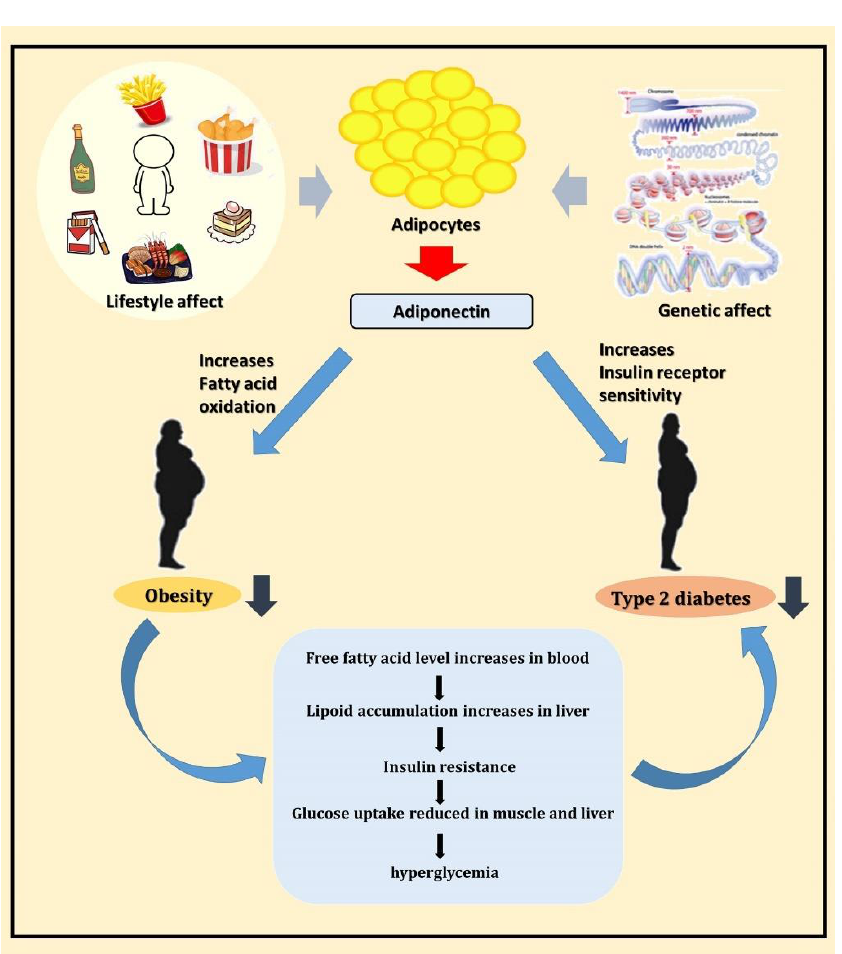
Figure 5. Schematic diagram showing the relationship between adiponectin, obesity, and